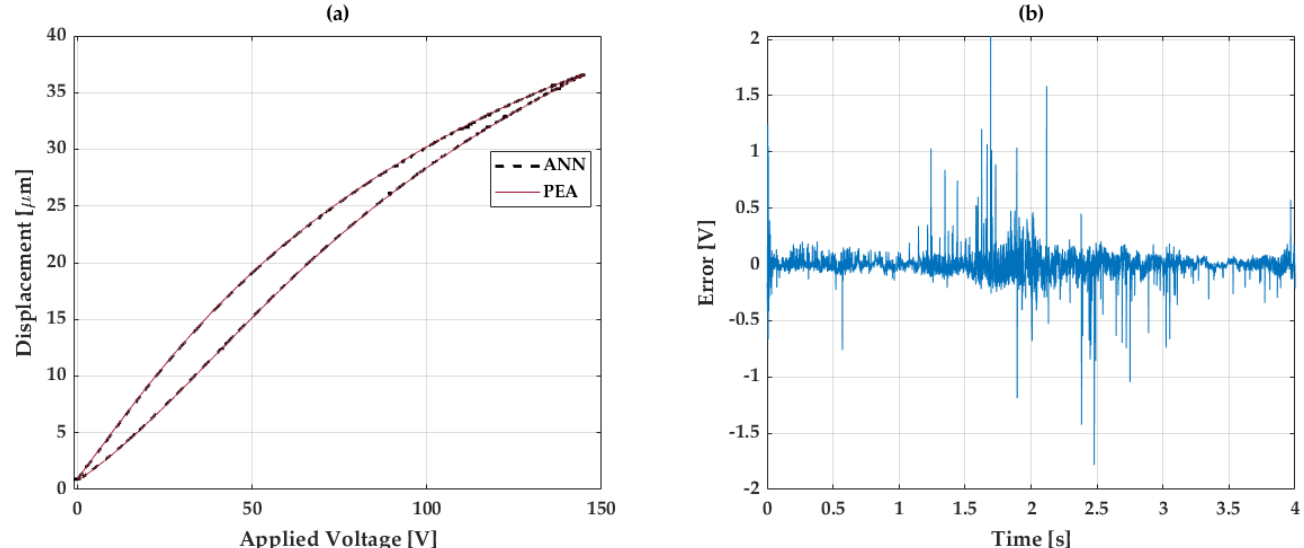
Figure 5. Ability of the ANN to fit to the PEA nonlinearity, where: ( a ) is the hysteresis graph contrast and ( b ) the error of the